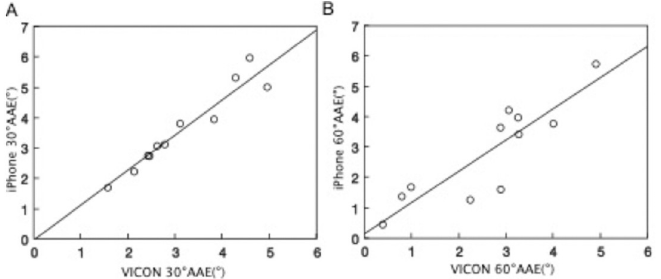
Fig 2. The relationship between AAE values of the iPhone and VICON. (A) 30˚AAE (Pearson’s r = 0.960; P < 0.001). (B) 60˚AAE (Pearson’s r = 0.879; P < 0.001). AAE: absolute angular